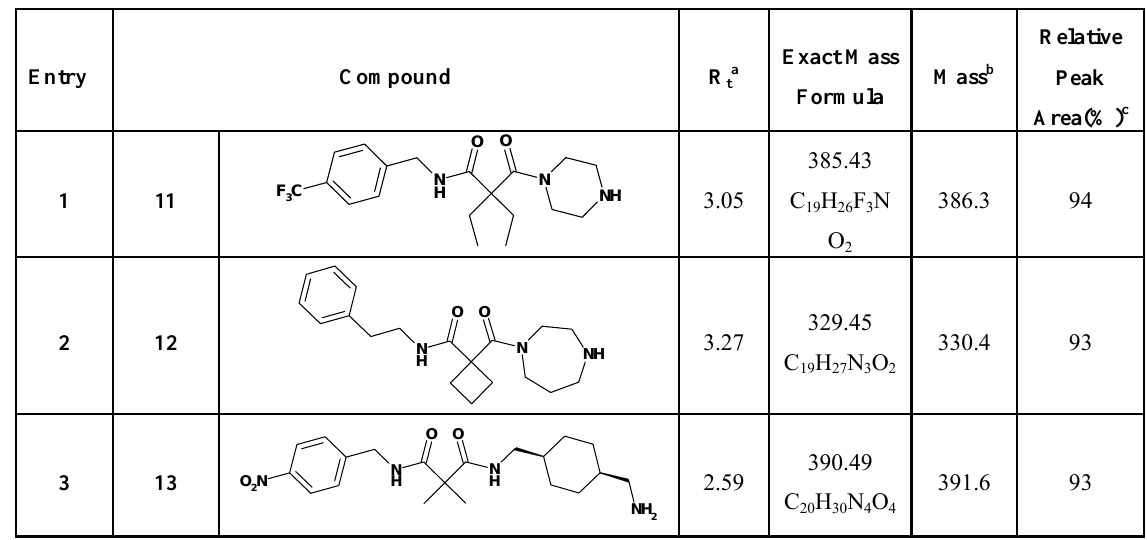
Table 1. Solid-phase synthesis of malonamides